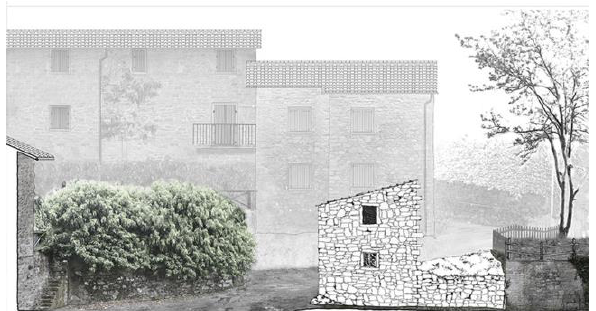
Figure 3A. Survey elevation on the road of the source with the design of the small building (Dryer) made when it was still intact, 1986 around.